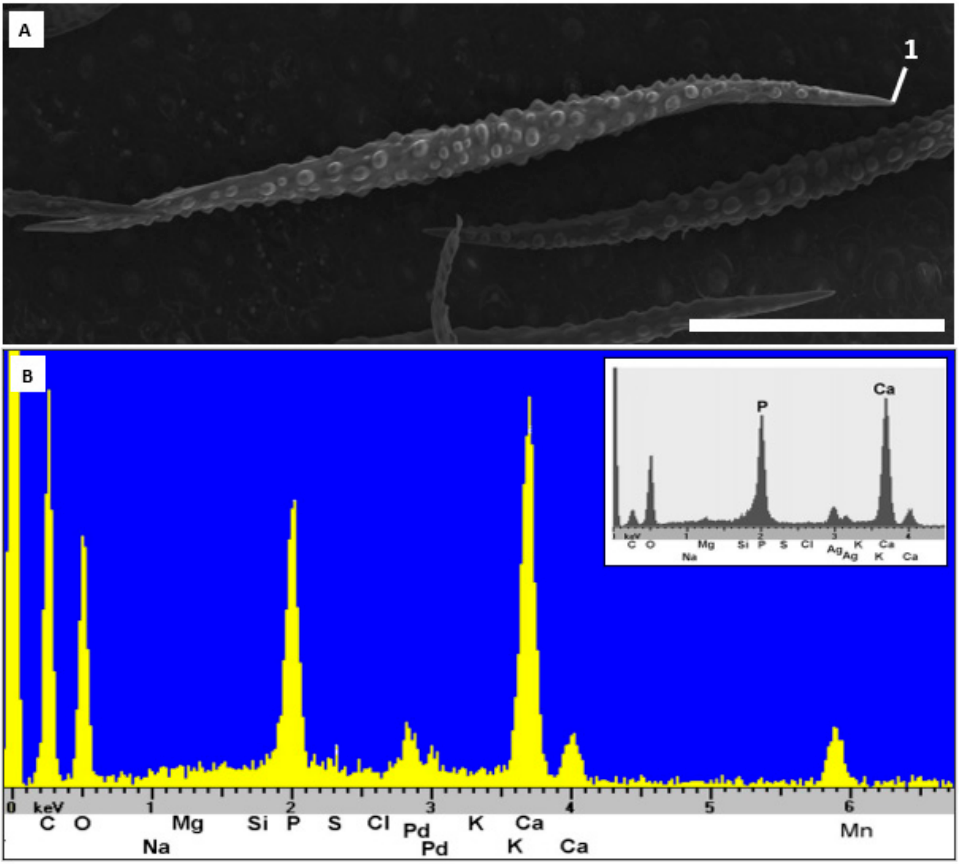
Figure 3. Cultivated Bornmuellera emarginata trichome (calcareous soil; accession 40470, BONN). ( A ). Secondary electron image of characteristic malpighiaceous trichome. ( B ). Energy-dispersive X-ray spectroscopy peaks at tip (spot 1) indicate a composition close to that of pure apatite-calcium phosphate (inset). Scale bar: 200 μ m.